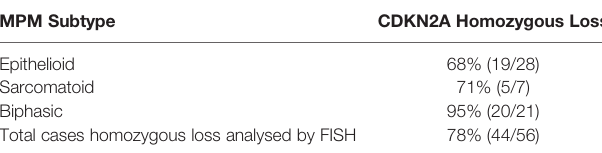
TABLE 3 | Proportion of CDKN2A homozygous loss according to malignant pleural mesothelioma (MPM) subtype.